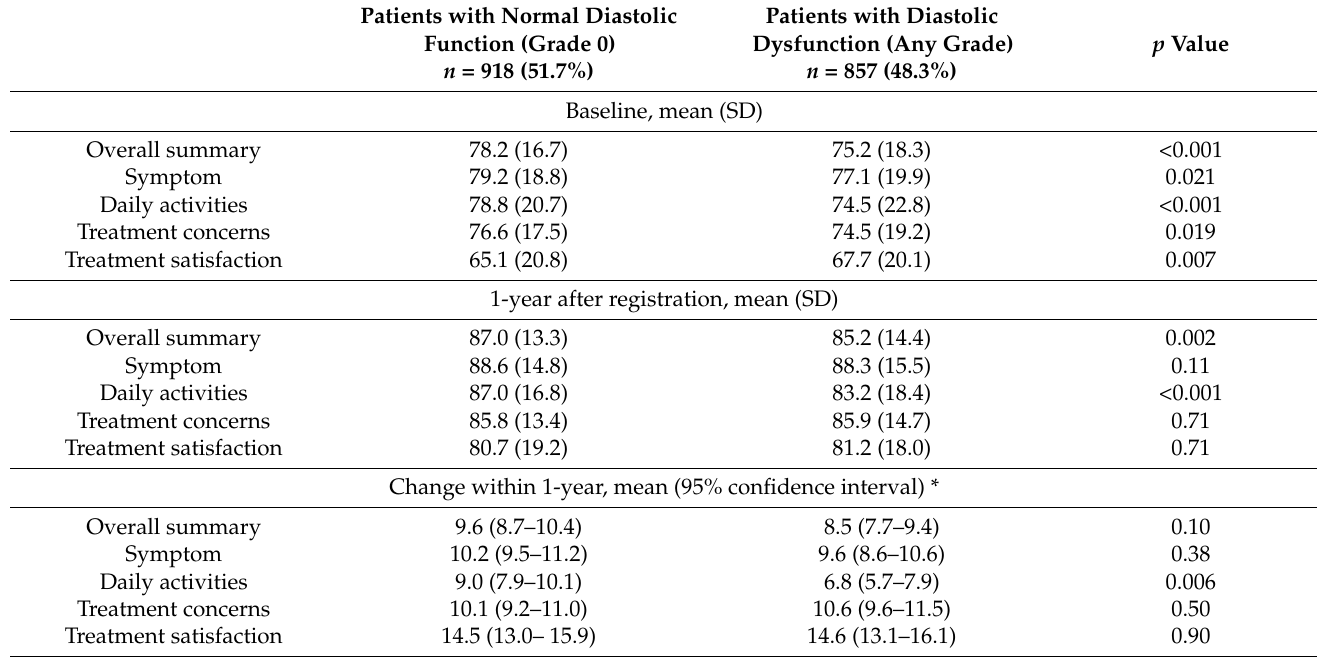
The Atrial Fibrillation Effects on QualiTy-of-Life outcomes across patients with diastolic